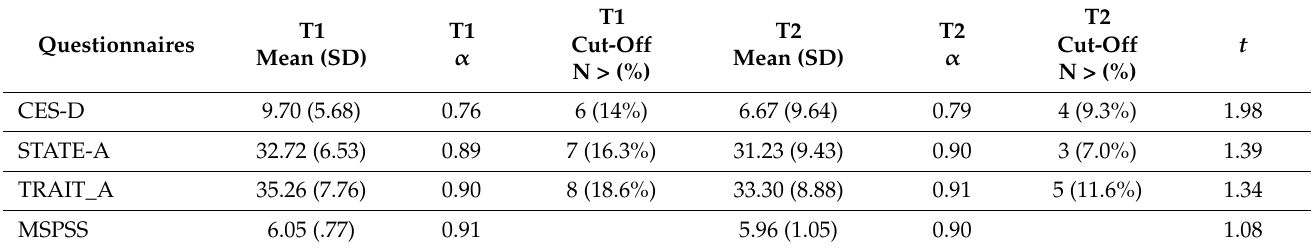
Table 2. Descriptive statistics of the questionnaires administered to the women at T1 and T2 (N = 43) and the number of women above the clinical cut-off.